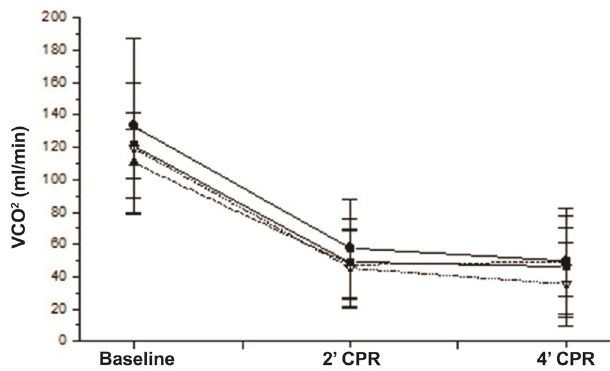
Fig. 2 – Comparative evolution of the variables assessed at baseline (0), 2 min of CPR (2) and 4 min of CPR in the groups studied. Average value and standard deviation of VCO 2 in each moment and group.